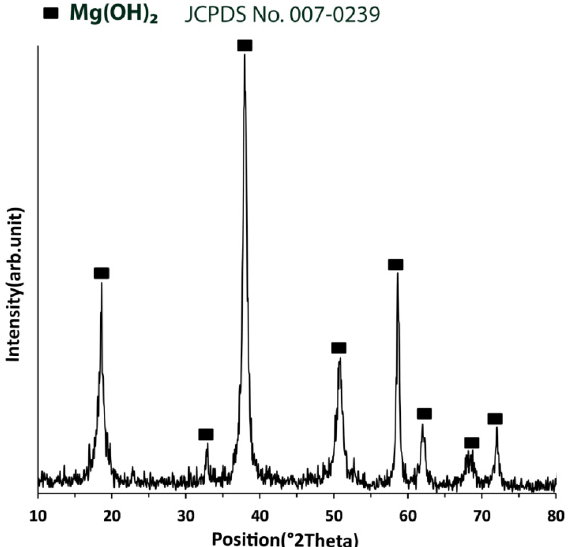
Figure 16. The XRD pattern of the corrosion product of the 0.75Ti sample following immersion in 3.5 wt.% NaCl solution.